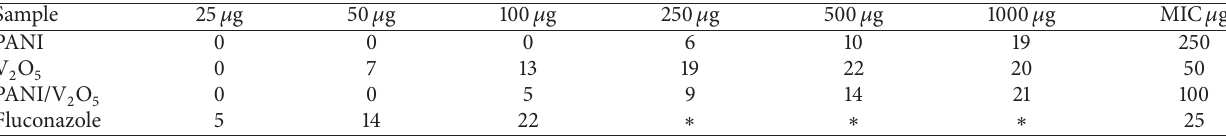
Table 2: Antifungal activity results, zone of inhibition in mm (A. niger)